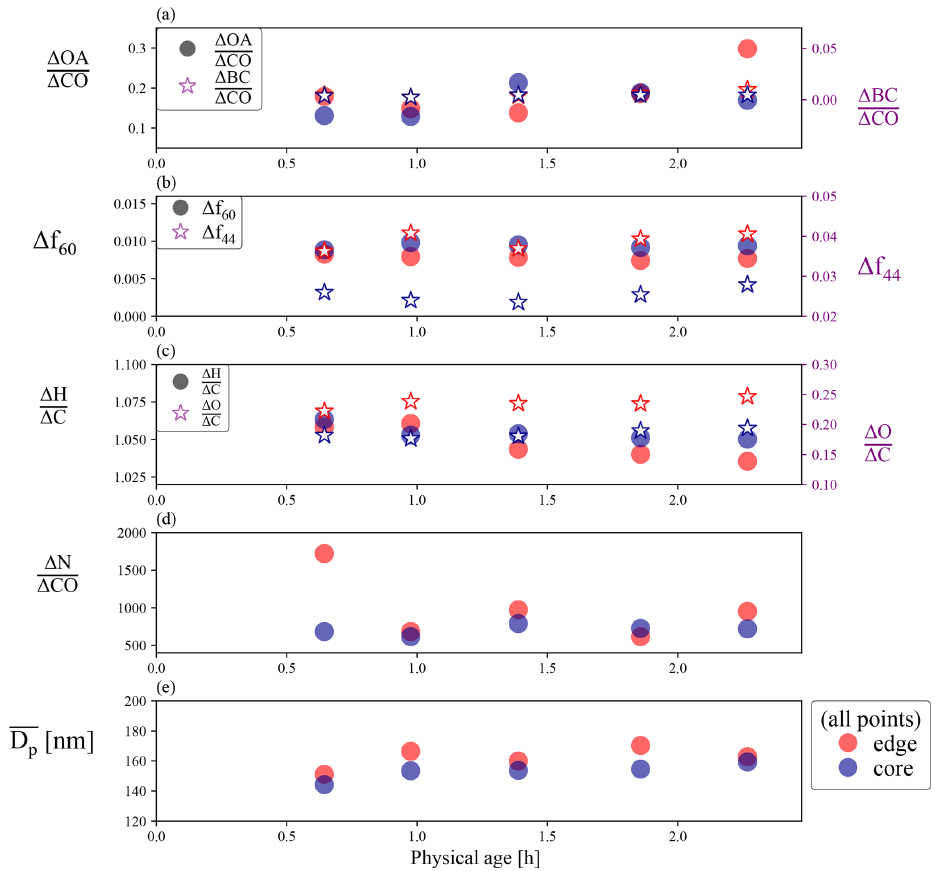
Figure 1. Aerosol properties from the first set of pseudo-Lagrangian transects from the Colockum fire on flight “730b”: (a) (cid:49) OA /(cid:49) CO (right y axis) and (cid:49) BC /(cid:49) CO (left y axis), (b) (cid:49)f 60 (right y axis) and (cid:49)f 44 (left y axis), (c) (cid:49) H /(cid:49) C (right y axis) and (cid:49) O /(cid:49) C (left y axis), (d) (cid:49) N /(cid:49) CO, and (e) D p against physical age. For each transect, the data are divided into edge (the lowest 5%–15% of (cid:49) CO data; red points) and core (90%–100% of (cid:49) CO data; blue